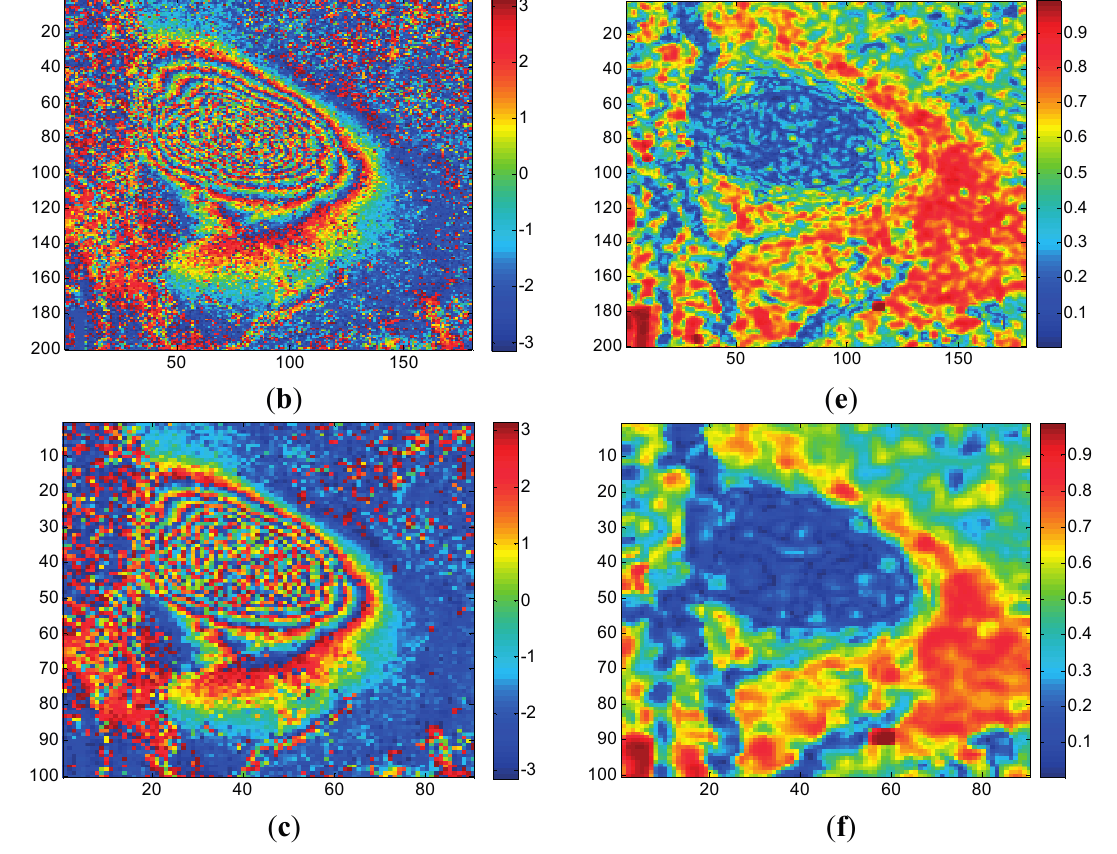
Figure 2. Interferograms (left) and coherence maps (right) under different numbers of multi-looks in the working face 18a203: ( a ) interferogram of 1 × 1 look; ( b ) interferogram of 2 × 2 looks; ( c ) interferogram of 4 × 4 looks; ( d ) coherence map of 1 × 1 look; ( e ) coherence map of 2 × 2 looks; ( f ) coherence map of 4 × 4